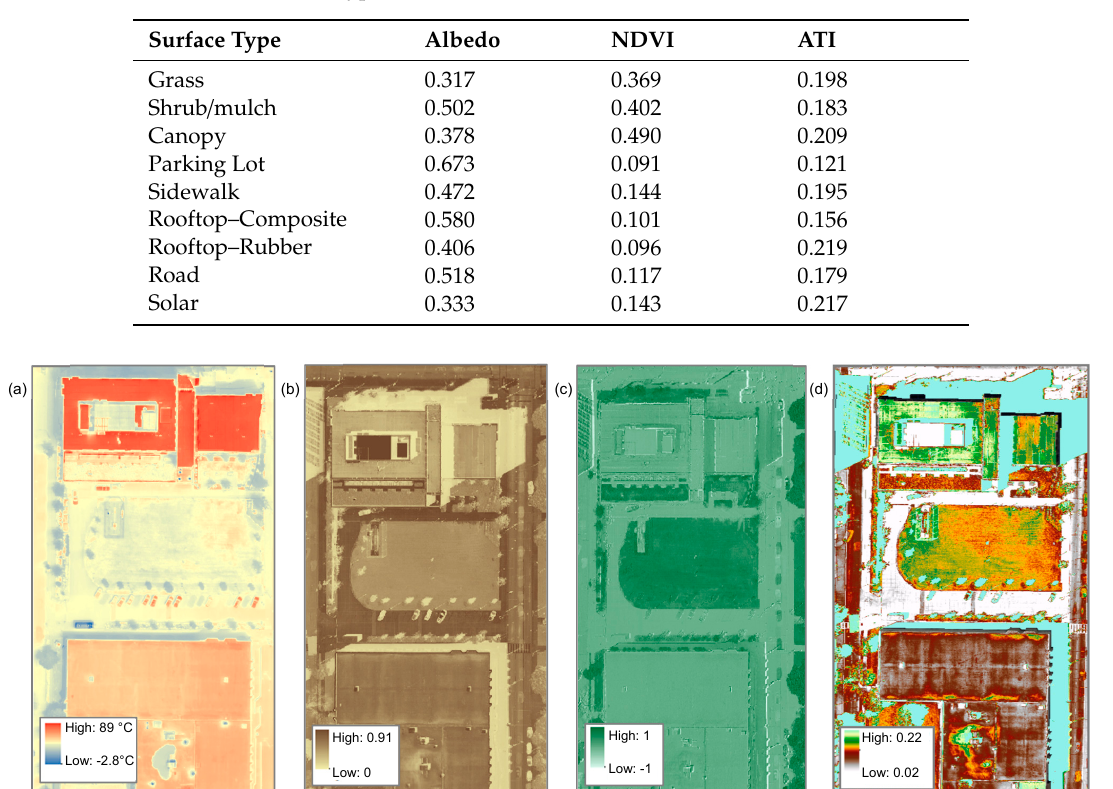
Table 6. Average albedo, normalized difference vegetation index (NDVI) and apparent thermal inertia (ATI) values for each surface type.